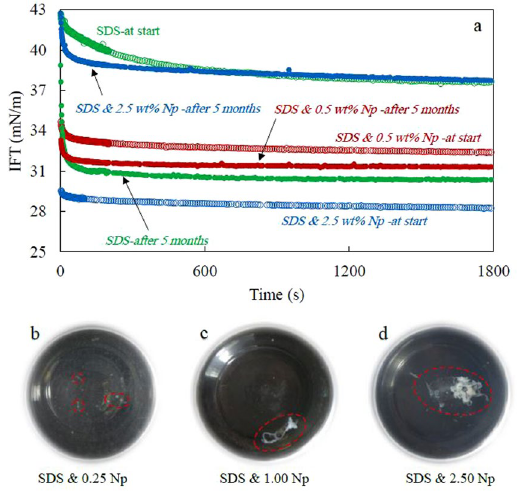
Figure 9. ( a ) Dynamic IFT of heptane/SDS solution mixed with different concentration of nanoparticles (Levasil 300/30, 9 nm) measured at two time-period, just after preparation of fluids (Empty points) and five months later (Filled points), ( b – d ) Bottles containing the aged solutions containing nanoparticles from the bottom view which show the formation of a white solid precipitate (nanoparticles-SDS impurity